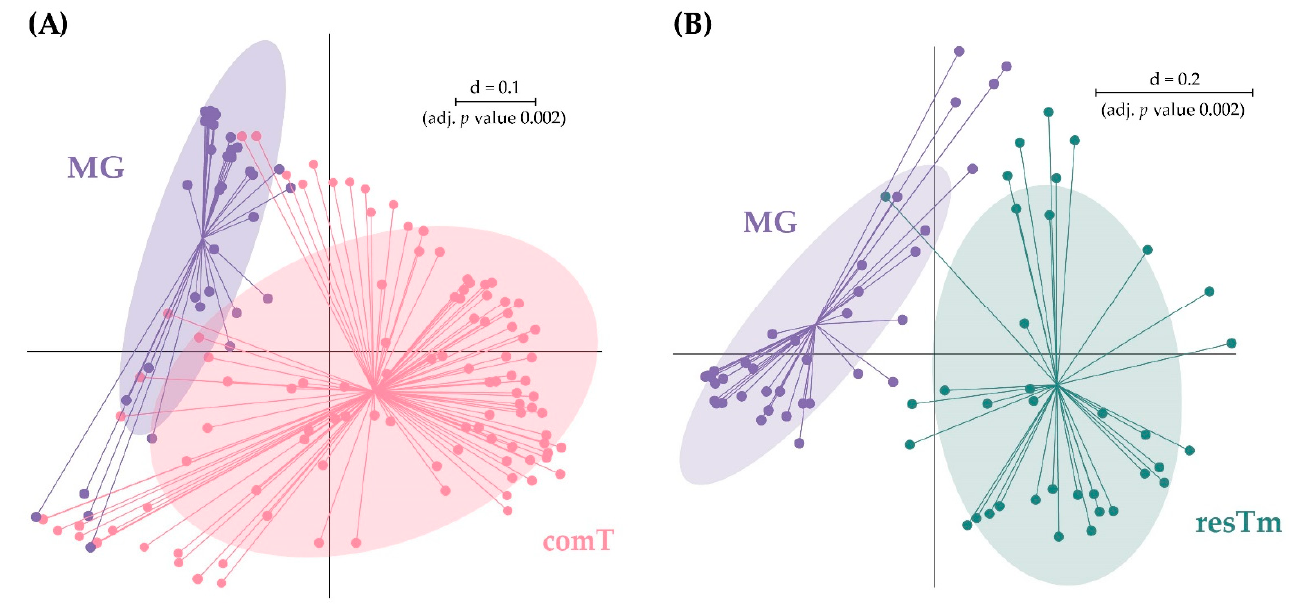
Figure 6 . Pairwise β -diversity of the groups ( A ) MG and comT as well as ( B ) MG and resTm displayed as multidimensional-scaling (MDS) plot. The scale is an indicator for the differences in the phylogenetic makeup of microbiota between samples ( β -diversity) based on general UniFrac distances (d = 0.1, 10% difference). comT, complete Ixodes ricinus tick; resTm, residual tick materials; MG, midgut.